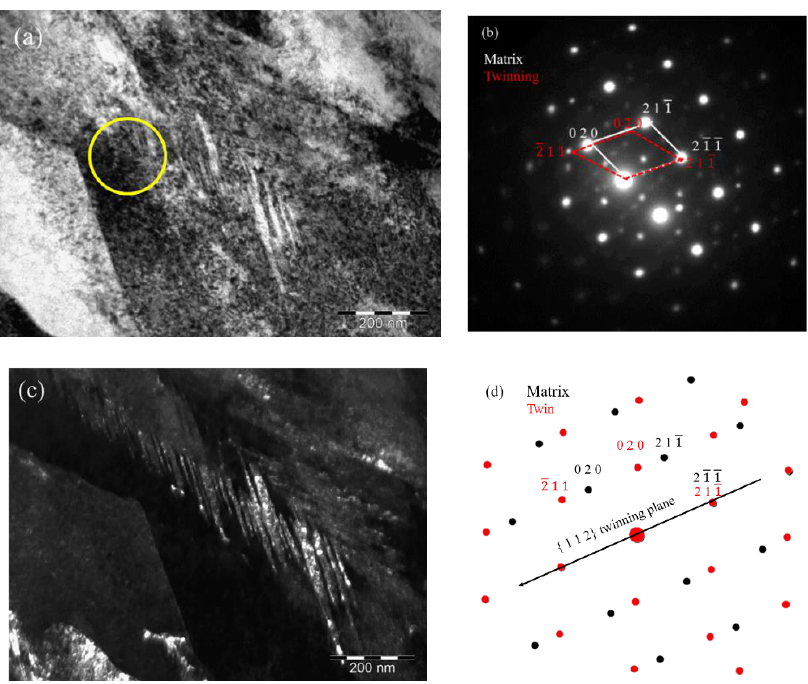
Figure 7. ( a ) A BF image of the WEL surface in the TEM foil; ( b ) Selected area diffraction (SAD) pattern, corresponding to zone axis [102] matrix of the region enclosed in the yellow circle; The ( c ) DF (cid:0) (cid:1) ( ) ( ) image formed from the 211 reflection of the twinning plane and ( d ) simulated diffraction pattern corresponding to ( b ).